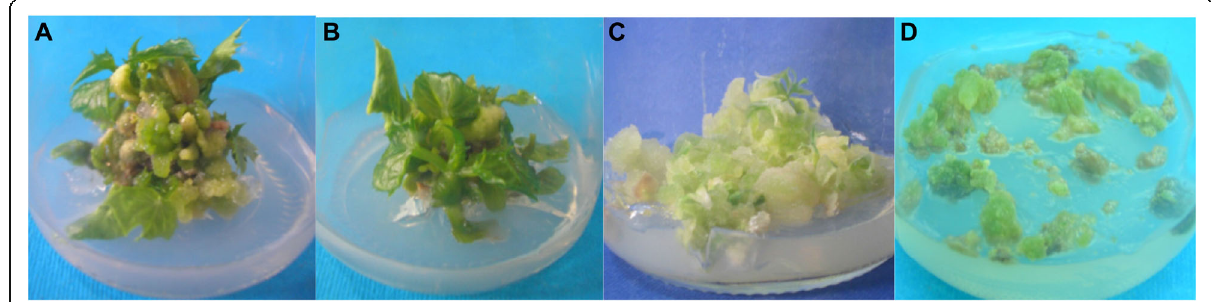
Fig. 2 Shoots regenerated from J. curcas leaf-derived callus cultured on MS medium with 2.0 mg/l BA + 0.2 mg/l IBA ( a ), 1.0 mg/l BA + 0.1 mg/l IBA ( b ), 0.5 mg/l BA + 1.0 mg/l 2,4-D ( c ), and control ( d ), after 6 weeks of cultivation